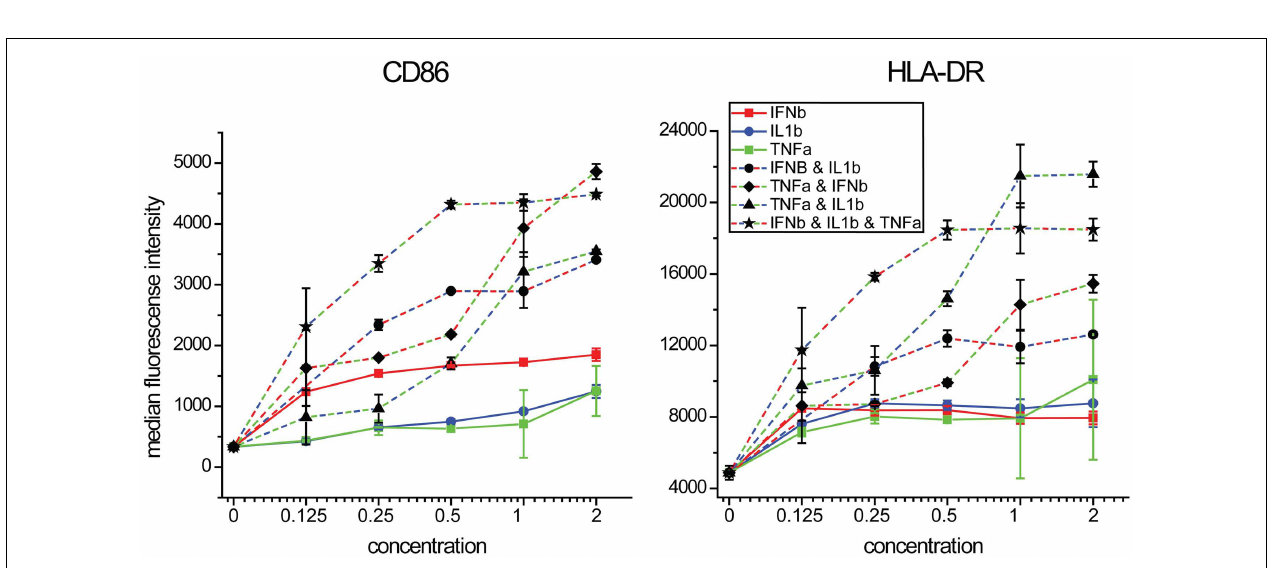
COMBINATORIAL EFFECTS OF TNF α , IL1 β , AND IFN β ON PATHOGENIC